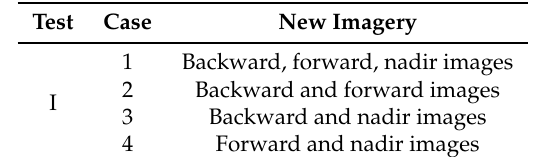
Table 4. ZY-3 images for georeferencing with the conventional method.